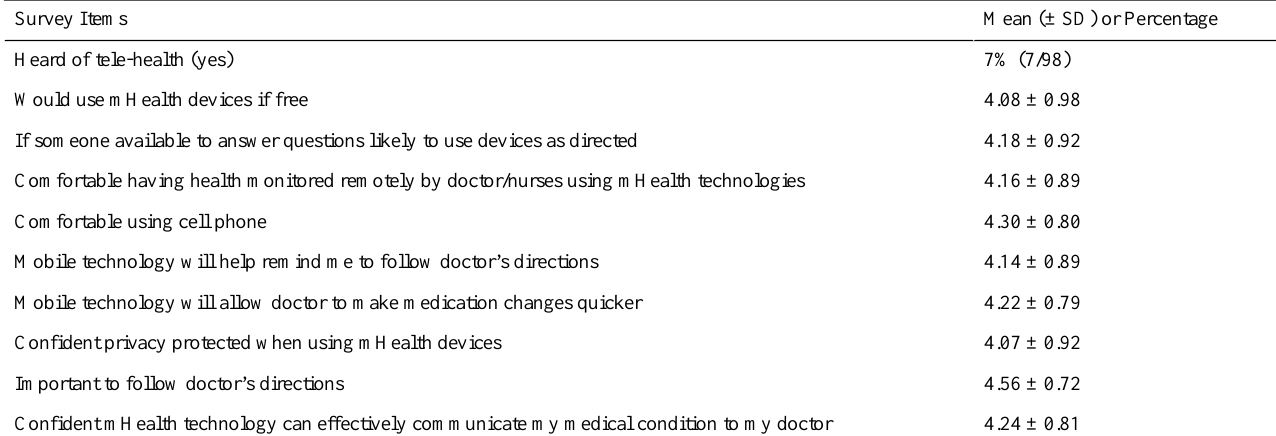
Table 2. Responses to mHealth related